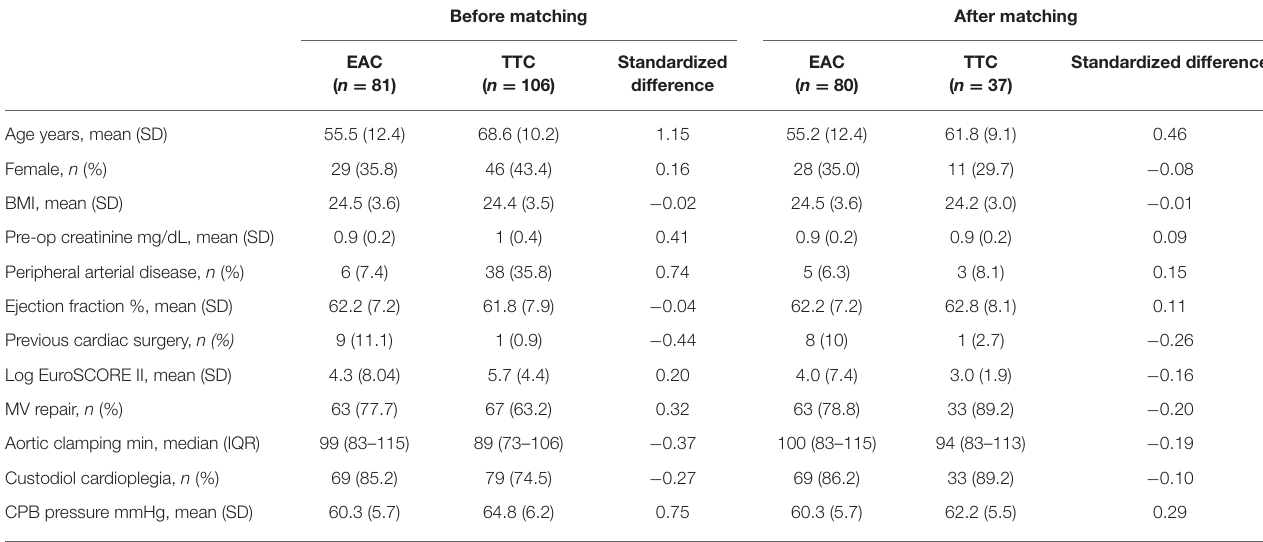
TABLE 1 | Patients’ characteristics and operative data before and after matching.